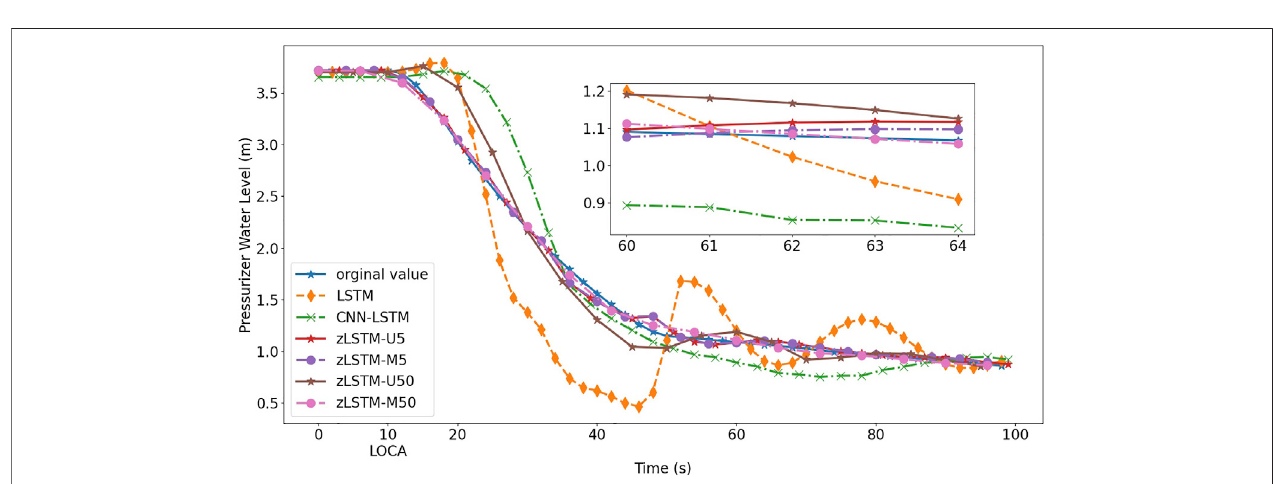
FIGURE 7 | Prediction of pressurizer water level on break size 0.95 cm.